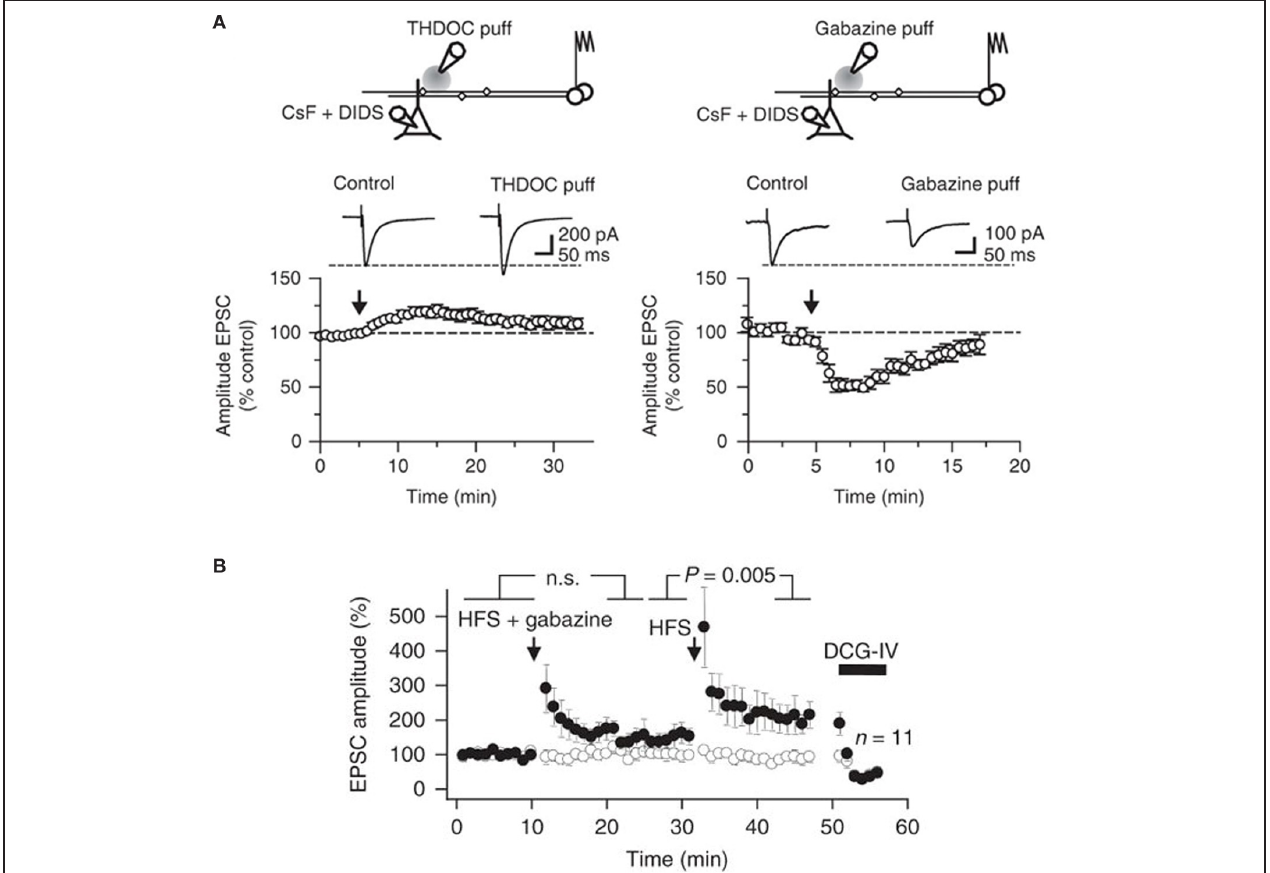
FIGURE 4 | Bidirectional modulation of synaptic transmission via tonically active GABA A receptors at mossy fibers. (A) Top, schematic illustrating the experimental design used to study presynaptic GABA A receptors at mossy fiber—CA3 synapses. Postsynaptic GABA A receptors in CA3 pyramidal cells were blocked using an intracellular pipette solution containing CsF and DIDS. A pressure-application pipette containing THDOC (50nM, left) was positioned ∼ 50–200 μ m from the apical dendrite of the recorded neurons. Bottom, time course of the effects of pressure application of THDOC (left; n = 8). Traces are averages of 10 consecutive EPSCs before